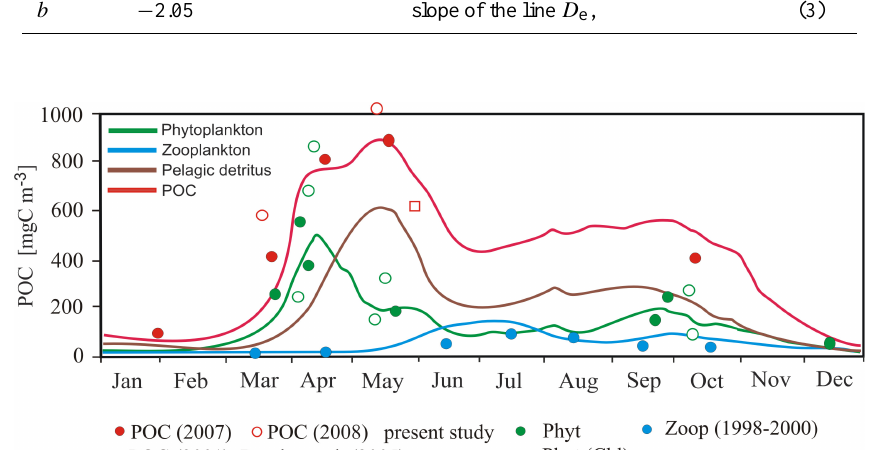
Fig. 2. Modeled POC seasonality presented against background of Phyt, Zoop and DetrP and in situ measured POC concentrations in the surface layer; solid line – POC, dashed line – phytoplankton, dash-dotted line – zooplankton, dotted line – pelagic detritus, full circles – data of POC from 2007, open circles – data of POC from 2008 (Dzierzbicka-Glowacka et al., 2010), open square – data of POC from 2001 (Burska et al., 2005). The same scale for all the variables (mgCm − 3